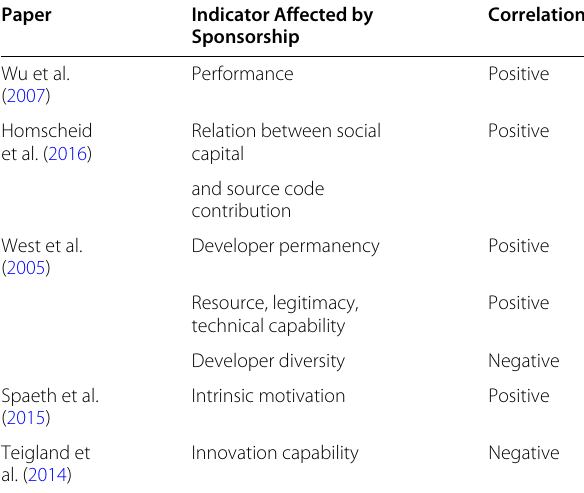
Table 7 The indicators about